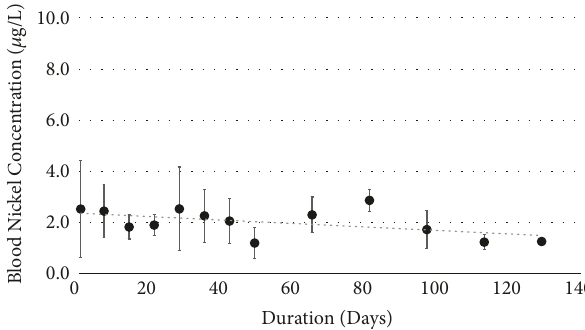
Figure 13: Ovine nickel blood level over six months exhibiting a decreasing